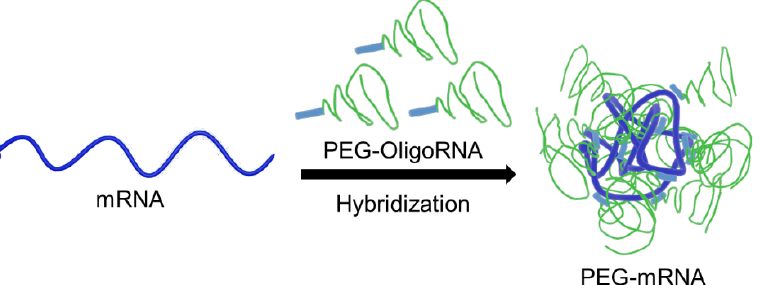
Figure 1. Schematic illustration of PEG-mRNA. mRNA is directly PEGylated through hybridization of PEG-OligoRNA, and the PEG strands protect mRNA from enzymatic degradation.